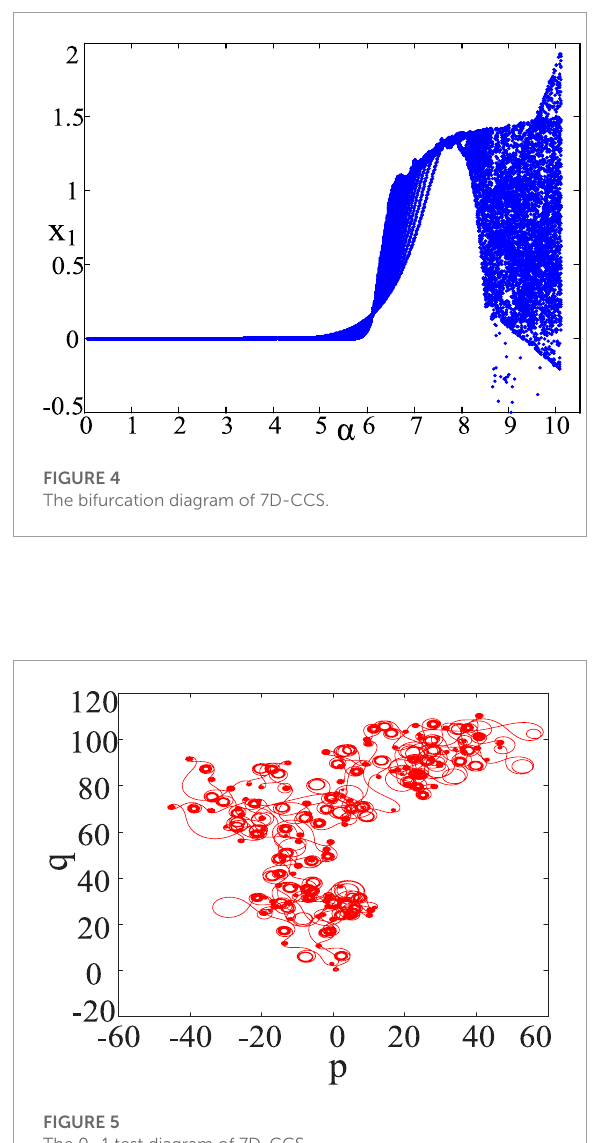
FIGURE 5 The 0–1 test diagram of